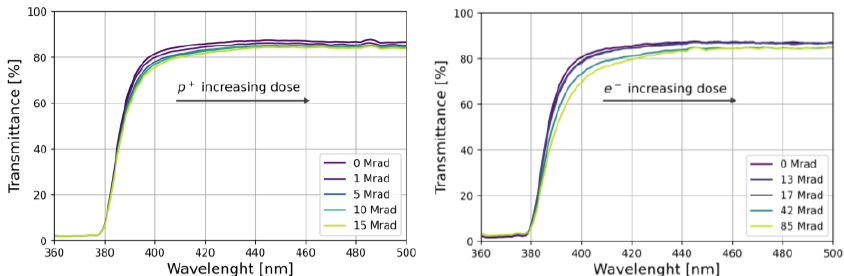
Figure 8. Light transmission spectra for PEN scintillators irradiated with protons ( left ) and electrons ( right ).